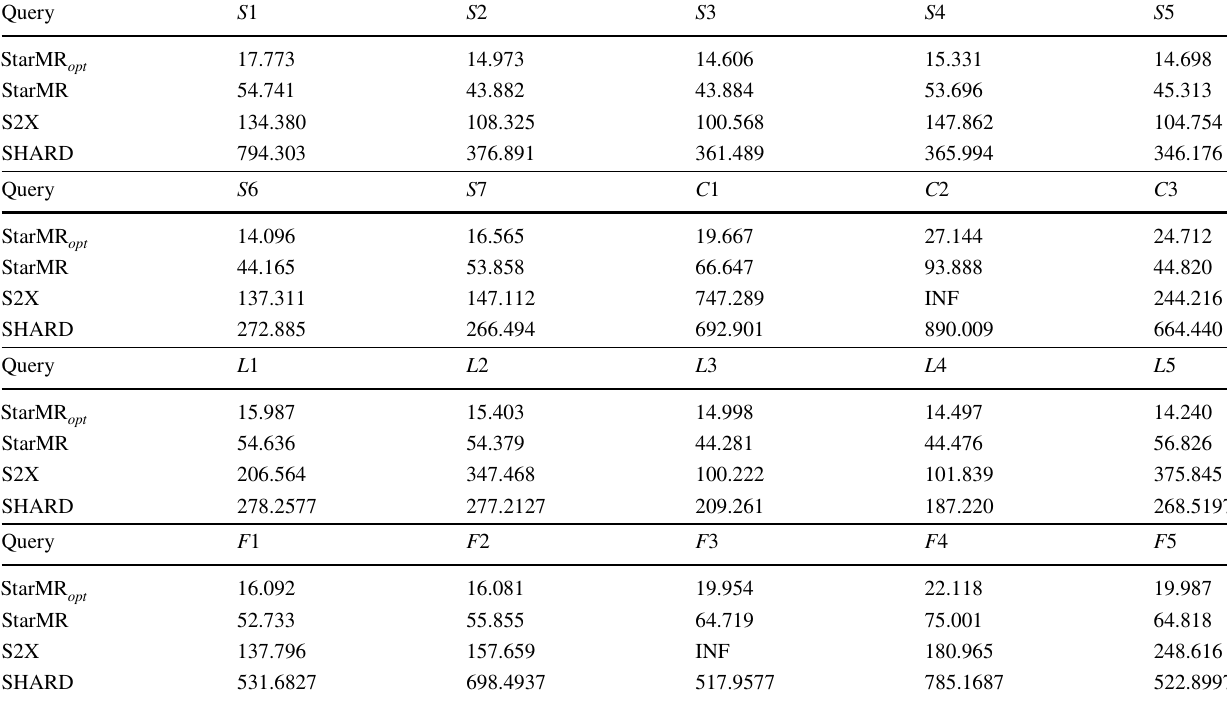
Table 4 The query times (in s) of StarMR opt , StarMR , S2X, and SHARD on WatDiv100M